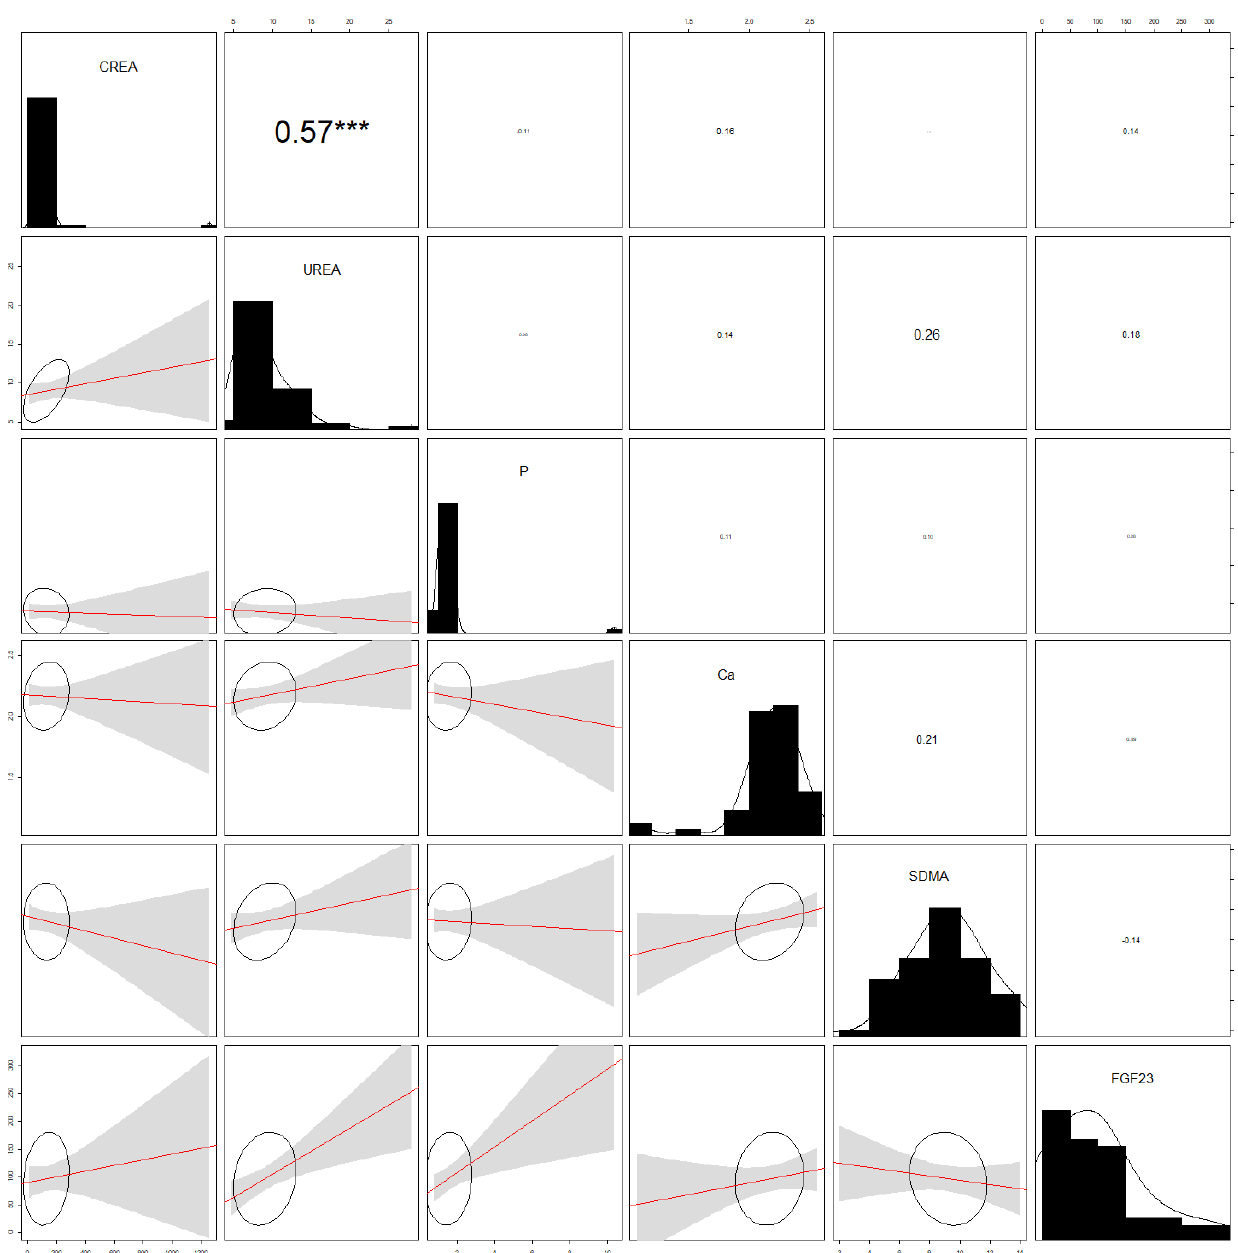
Figure 2. Analysis of correlations (correlograms) among levels of selected parameters in healthy cats. CREA, creatinine; P, phosphate; Ca, calcium; SDMA, symmetric dimethylarginine; FGF 23, fibroblast growth factor 23. The coefficients of Pearson product-moment correlation are reported. Significance is given by *** p < 0.001.